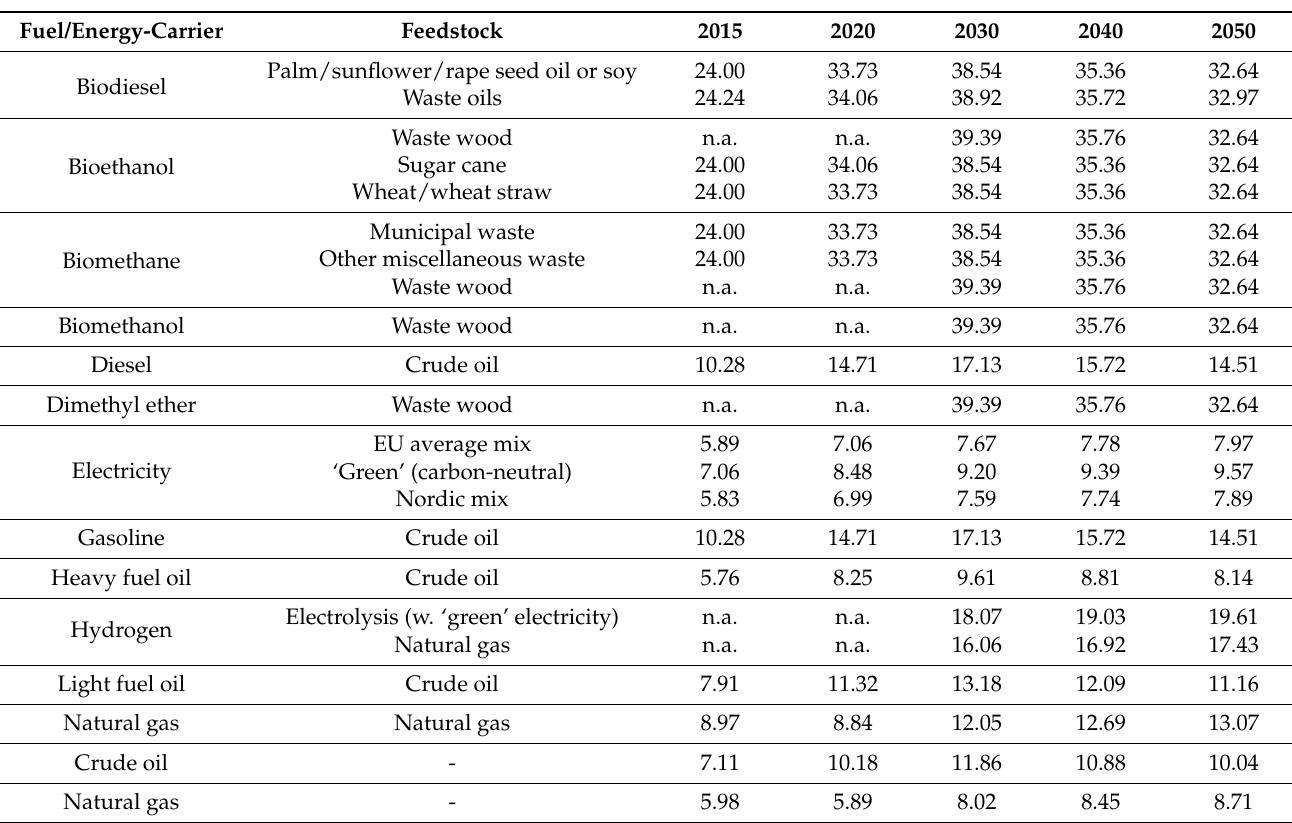
Table A4. Fuel/energy-carrier cost assumptions ( € 2015/GJ), excluding all taxes and delivery/infrastructure costs. Crude oil and natural gas cost projections added for reference.